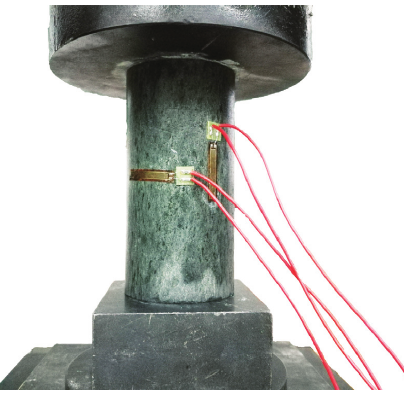
Figure 1: A view of the test instrument.